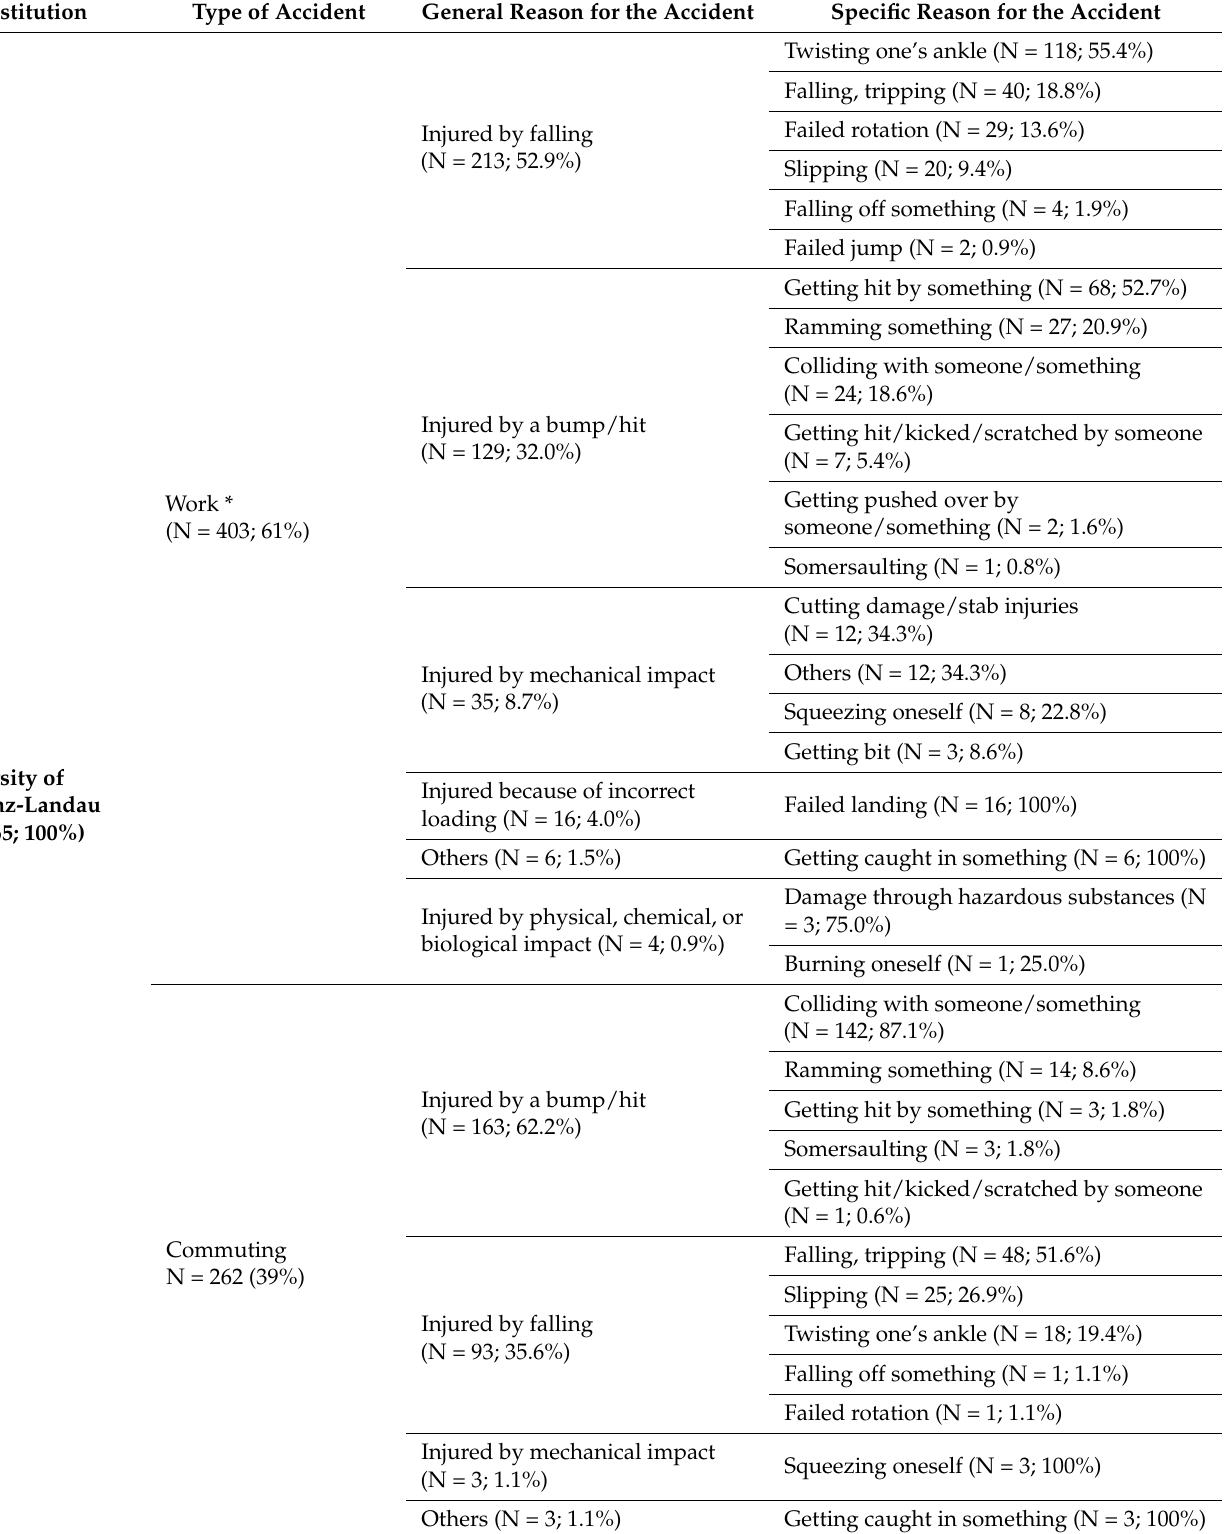
Table 2. Characteristics of students’ accidents at the University of